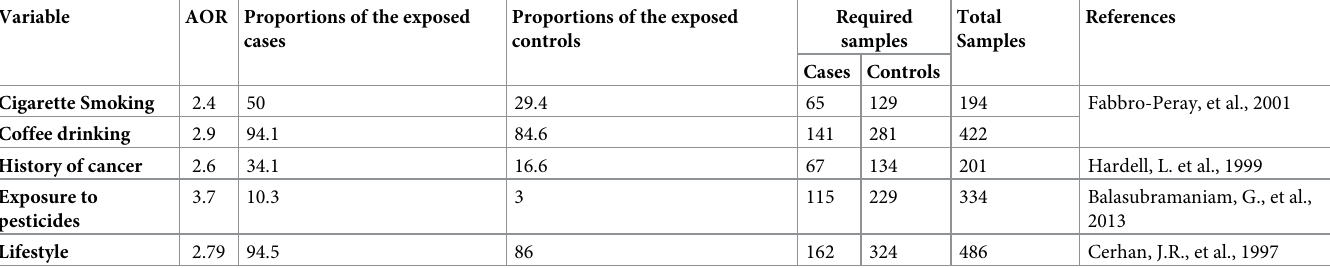
Table 1. Determinants for the sample size estimation of non-Hodgkin’s lymphoma at Felegehiwot specialized hospital, northwest Ethiopia, 2019.